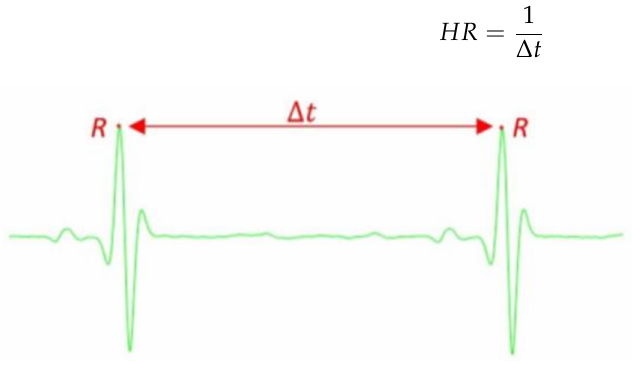
Figure 3. Time interval between two consecutive